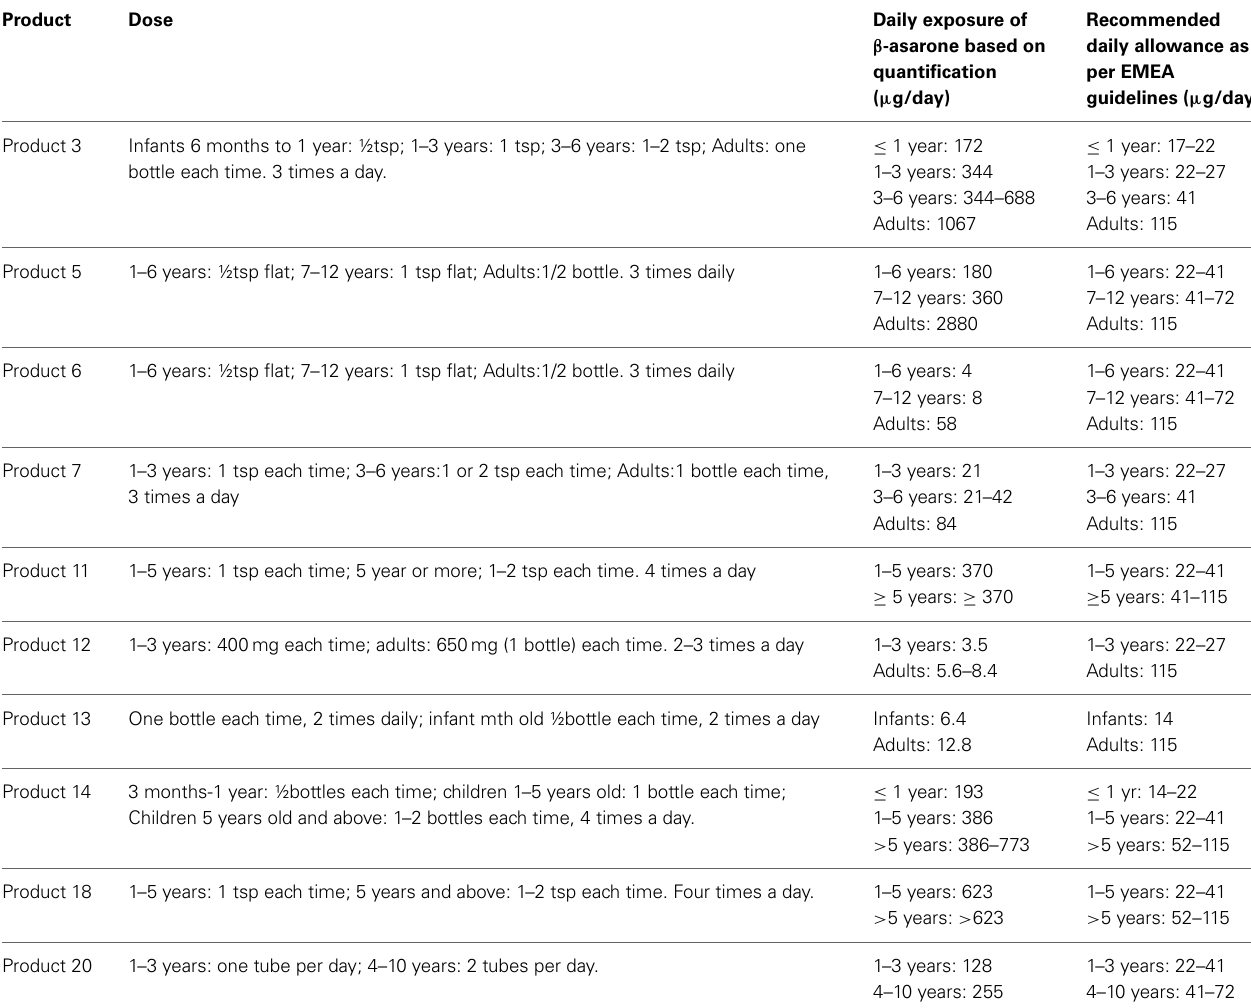
Table 4 | Estimation of daily exposure levels of β -asarone in herbal products for children. Product